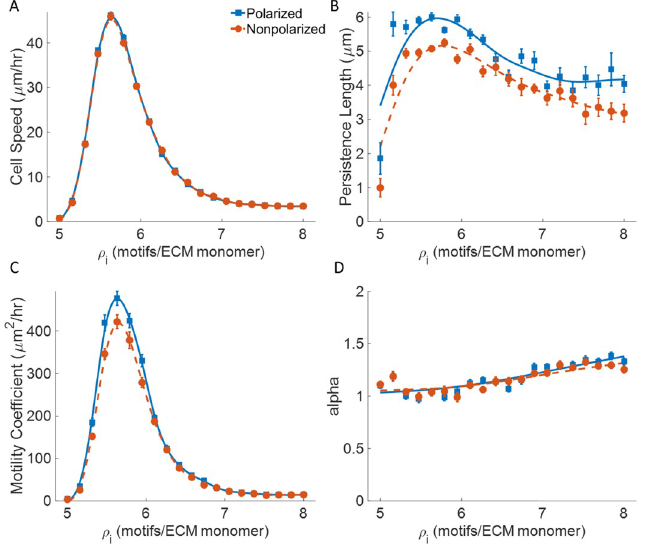
Fig 2. Effect of binding site density. Plots for v avg , L p , μ , and α as a function of increasing binding site density A) Cell speed B) Random motility coefficient C) Alpha D) Persistence length. C gel = 3.7 mg/ml, ρ fiber = 1.0 x 10 − 3 fibers/ μ m 3 , AI = 0, and t search = 16s. Simulation time = 60 hrs. n = 20. Solid blue lines are polarized cells ( ◼ ), dashed red lines are nonpolarized cells ( ● ). Error bars represent ± SEM. Splines added to emphasize